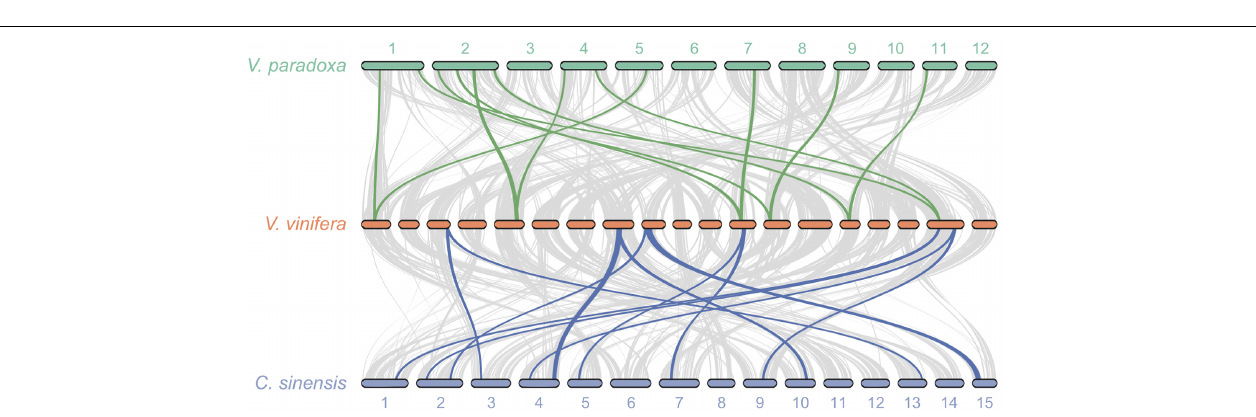
FIGURE 3 | K S age distributions for paralogs of four species within the order Ericales: shea, Camellia sinensis (tea plant), Rhododendron simsii , and Actinidia chinensis (kiwifruit). The blue peak represents the recent WGD event in kiwifruit (A d - α ). The arrows represent adjustments to synonymous substitution rates based on relative rate tests (see text for details), suggesting a convergence of peaks at a likely shared WGD event in the Ericales (A d - β ). The well-established ancient WGD event (At- γ ) that pre-dates the Asterid-Rosid divergence is also indicated.